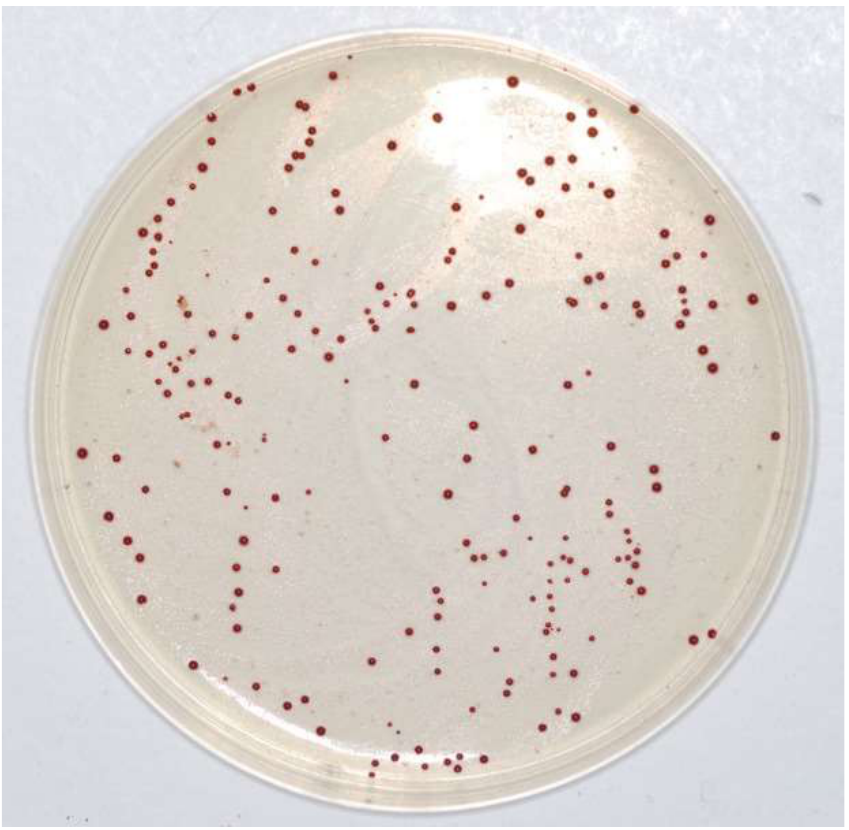
Figure 5. Enterococus casseliflavus on Barnes agar.